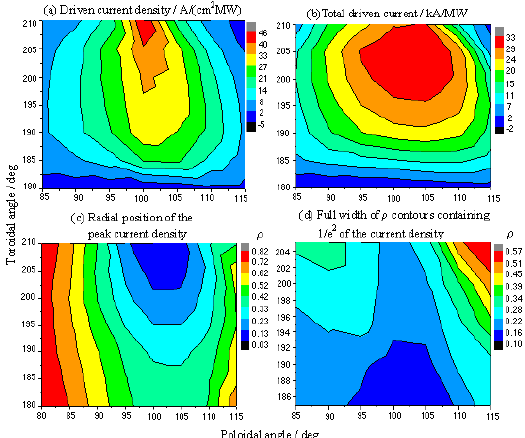
Fig. 2. Two-dimensional variation of ECCD characteristics with different poloidal and toroidal angles when B 0 = 2.2 T, Ra = 300 cm, and Za = 30 cm. (a) Driven current density in units of A·cm -2 ·MW -1 , (b) total driven current in units of kA·MW -1 , (c) radial position of the peak current density, and (d) full width of ρ contours containing 1/e 2 of the current density